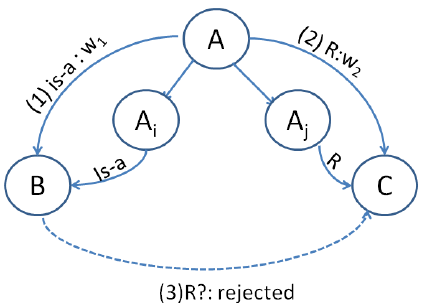
Induction scheme. Central Term A may be polysemous with meanings holding